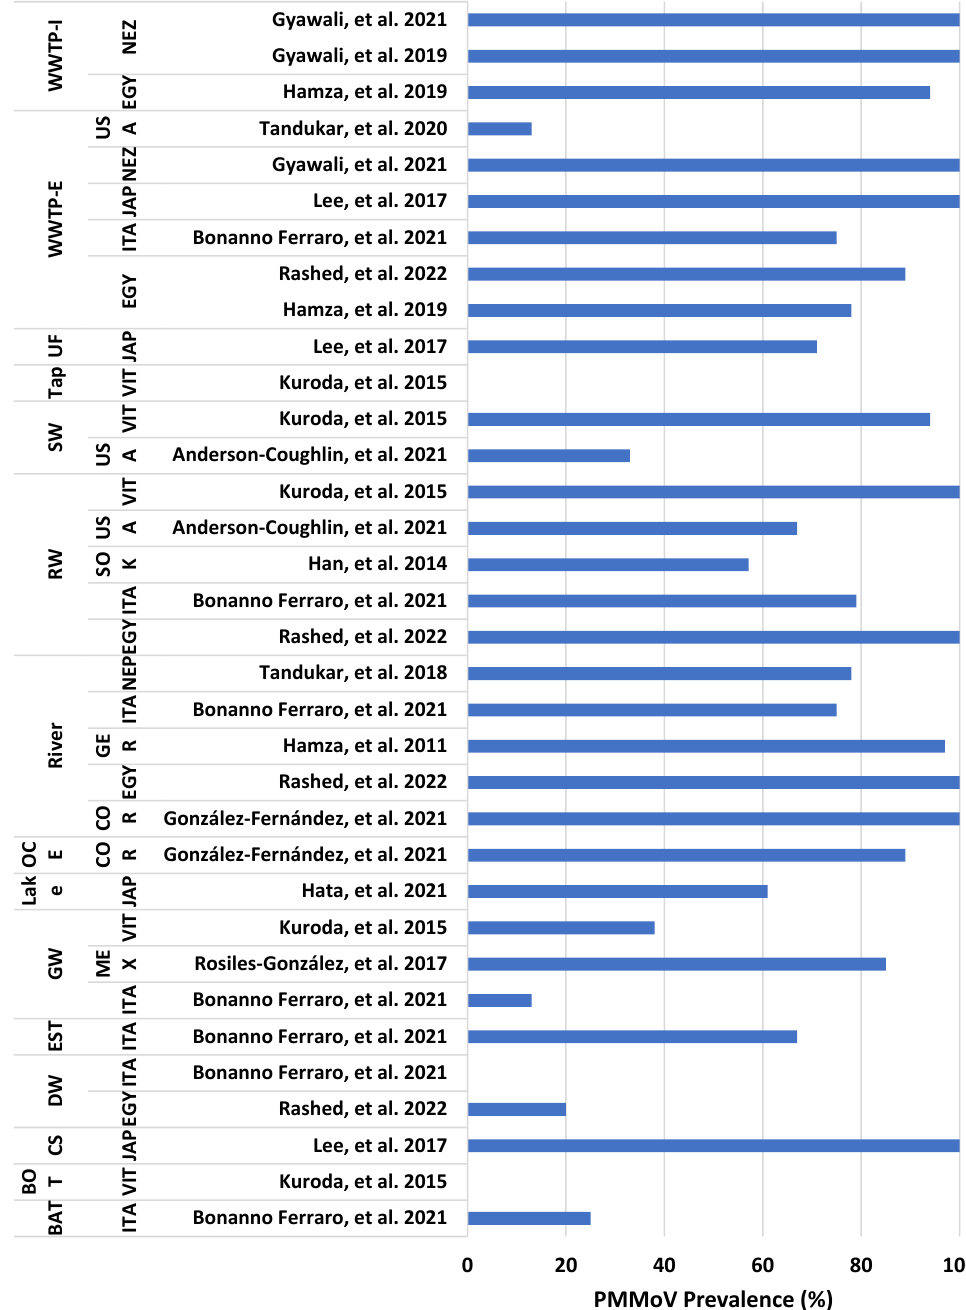
Figure 4. PMMoV prevalence in various water sources [136,145,150,152,157,161,177–192]. WTTP-I: wastewater treatment plant influents, WTTP-E: wastewater treatment plant effluents, UF: ultrafiltra- tion treated wastewater, SW: surface water, RW: raw sewage water, OCE: ocean, GW: groundwater, EST: estuarine water, DW: drinking water, CS: coagulation–sedimentation-treated wastewater, BOT: bottled water, BAT: bathing water. Countries included New Zealand (NEZ), Egypt (EGY), United States of America (USA), Japan (JAP), Italy (ITA), Vietnam (VIT), South Korea (SOK), Nepal (NEP), Germany (GER), Costa Rica (COR) and Mexico